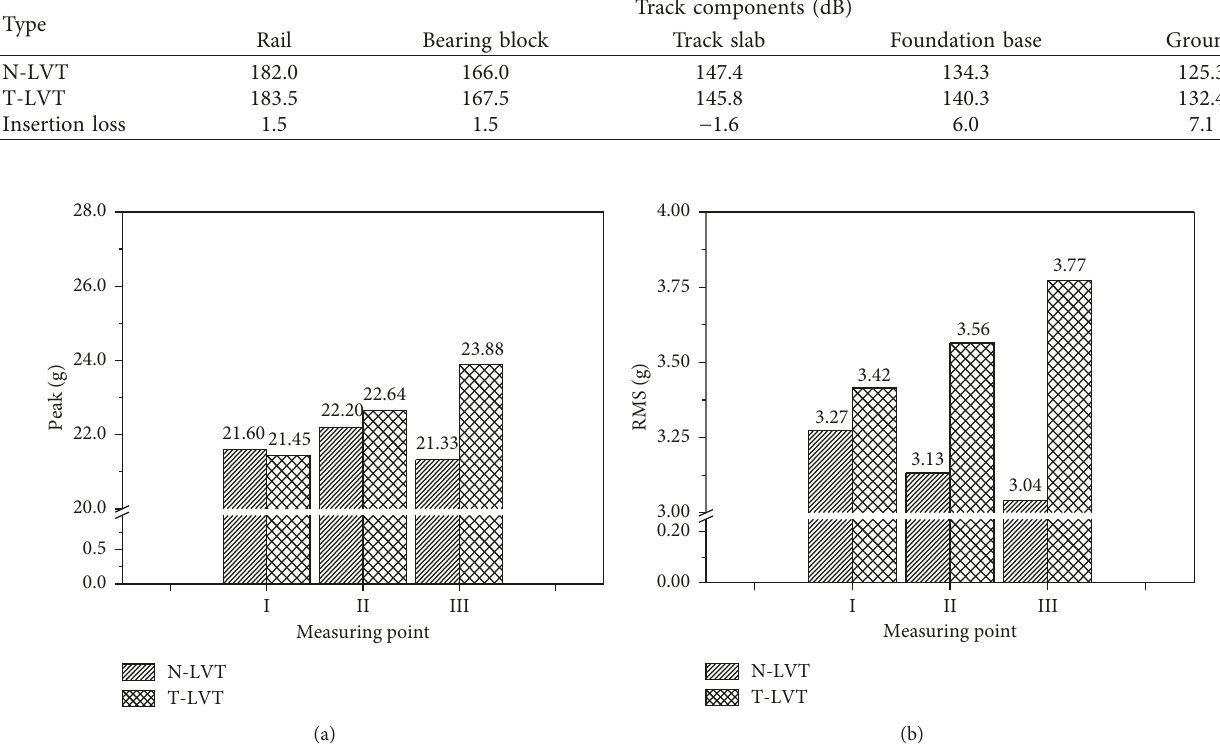
Figure 15: Bearing block acceleration peak and RMS. (a) Acceleration peak. (b) Acceleration RMS.